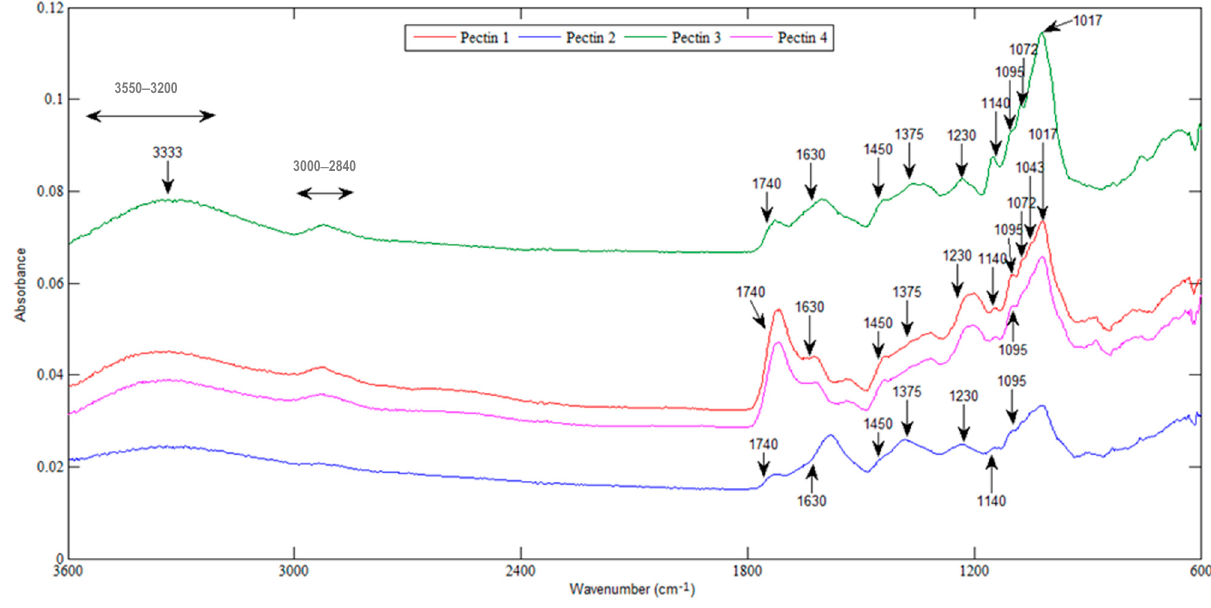
Figure 2. FTIR spectra of the pectins obtained from jabuticaba peel flour. Extraction methods 1 (red), 2 (blue), 3 (green) and 4 (pink).